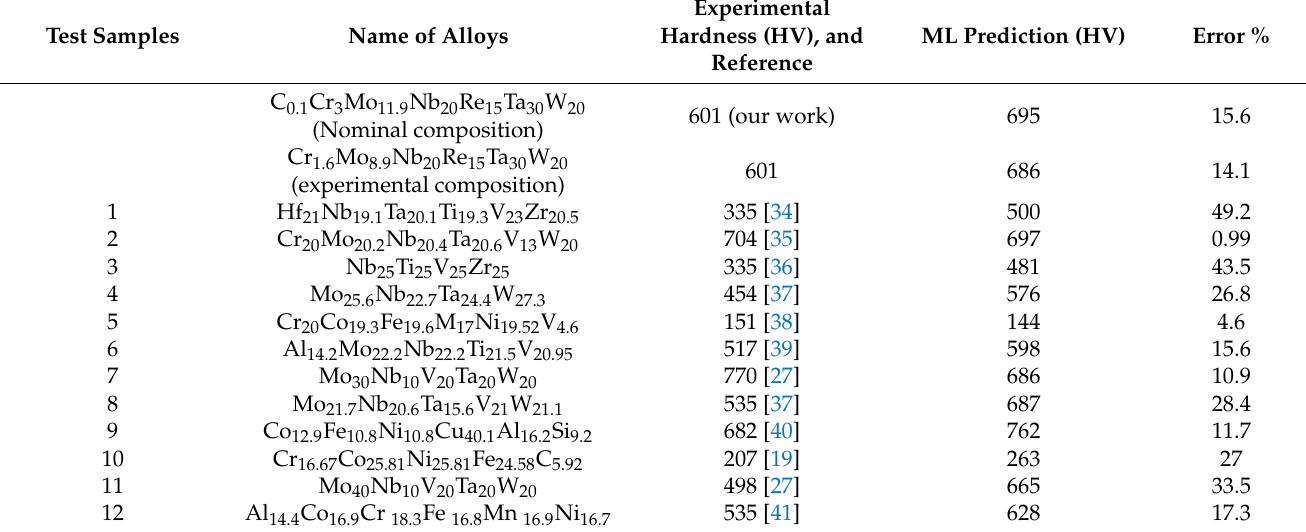
Table 2. Experimental and NN model-predicted Vickers hardness of HEAs.